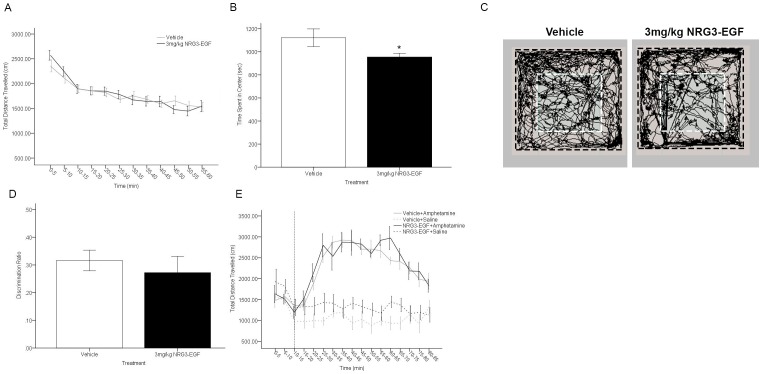
Overexposure to NRG3 during the neonatal period induces an anxiety-like phenotype in adulthood, but has no impact on locomotor activity or temporal order recency discrimination.(A) Total distance travelled in 5 minute intervals over a 1 hr exposure to the open field arena did not differ between NRG3-EGF or Vehicle treated mice (n = 12–14/treatment group). (B)Time spent in the center of the open field over a 1 hr period was significantly reduced in mice treated with NRG3-EGF as neonates compared to control treated mice (n = 12–14/treatment group). (C) Representative track plots of exploration in the open field of vehicle (left panel) and NRG3-EGF (right panel) overexposed mice. Inner area designated by white dashed line designates the center arena. (D) Adult mice treated with NRG3-EGF or vehicle during PND 2–10 performed successfully in the temporal order object recognition task of recency discrimination as adults (Discrimination ratio >0, n = 11–14/treatment group). (E) After a 10 minute period of habituation to the open field (indicated by dashed vertical line), mice neonatally overexposed to NRG3-EGF or vehicle were given a single i.p. injection of saline or 3 mg/kg amphetamine. No effect of treatment (NRG3-EGF) was observed on total distance travelled in 5 minute intervals of the subsequent 75 minutes in the context of amphetamine at a dose of 3 mg/kg (n = 6–7/group). Data represents mean ± s.e.m., *p<0.05 compared to vehicle treated mice.